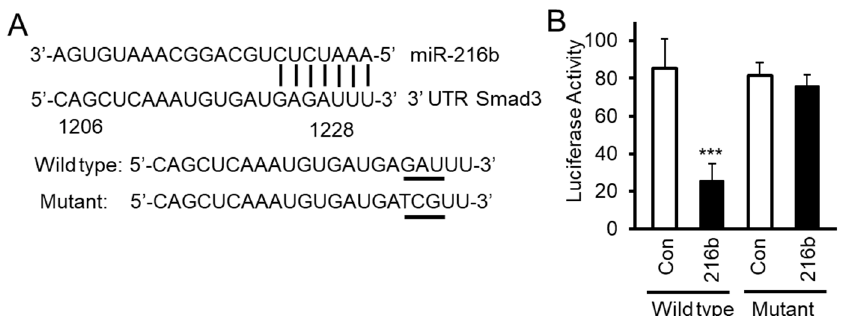
Figure 4. MiR-216b directly binds Smad3 gene 3 ′ end untranslated region (3 ′ UTR). ( A ) We have generated luciferase constructs by inserting wild type and mutated (3 base mutation GAU → TCG) 3 ′ UTR of Smad3 downstream of luciferase gene. ( B ) HPL1A cells were co-transfected with miRNA reporter vector with wild type Smad3 gene 3 ′ UTR containing miR-216b binding site or mutated site and miR-216b mimic or control miRNA mimic. Forty-eight hours after transfection, cells were harvested for luciferase activity assay. β -Galactosidase ( β -Gal) activity was used as an internal control ( n = 3, mean activity levels and SD are displayed). An unpaired Student’s t -test was used to analyze the statistical significance of differences between activity levels, *** P < 0.001, vs . control group (Con). These experiments were performed three times with similar results.